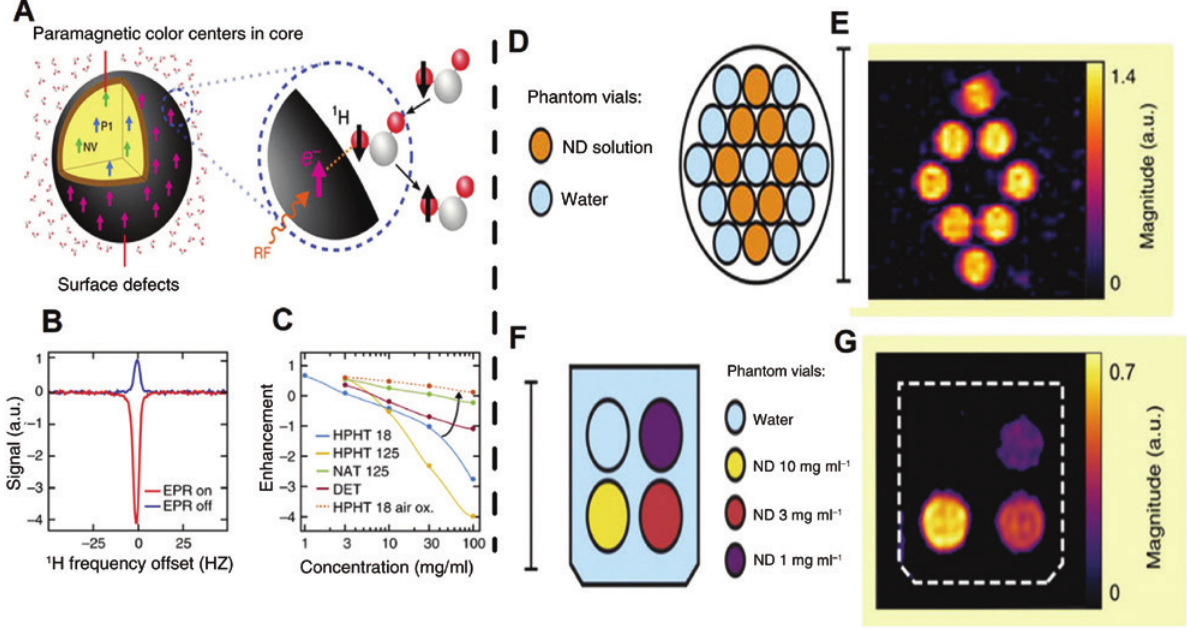
Figure 15: Hyper-polorization applications of nanodiamonds. (A) An illustration of the Overhauser effect at the ND–water interface. (B) Overhauser enhancement of 1 H polarization in an HPHT 125 nm (100 mg/ml) ND solution (red). While the thermal hyperpolarized 1 H spectrum is (blue). (C) Overhauser enhancement of 1 H polarization as a function of NDs concentration at 6 mT. (D) Vials of DI water (blue) and vials of HPHT 125 nm ND at 100 mg/ml (orange) were arranged in a pattern in an imaging phantom. (E) High contrast OMRI image with high signal to noise ratio from only the vials where NDs are present. (F) Imaging phantom prepared with vials with different concentration of ND solutions. (G) ODMR contrast images that change as a function of the NDs concentrations. Adapted from